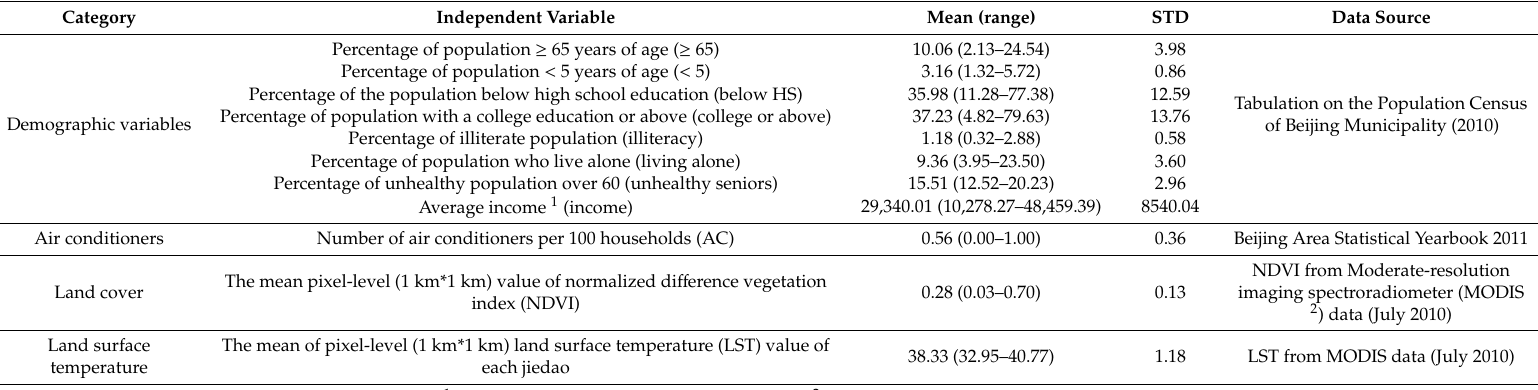
Table 2. Categories, variables, sources, means, and standard deviations (STDs) of heat vulnerability data at the jiedao scale (n =